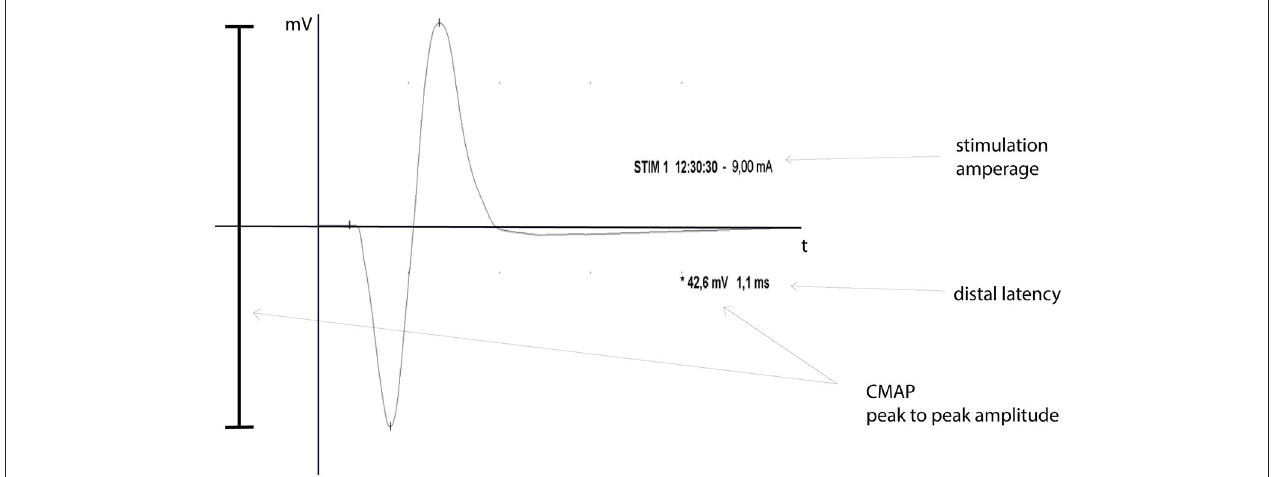
FIGURE 2 | CMAP graph. Shown is an exemplary CMAP-graph, including nerve stimulation time and -amperage (STIM), peak-to-peak CMAP amplitude in millivolt (*) and the distal latency in milliseconds, as a graphic EMG-data output.